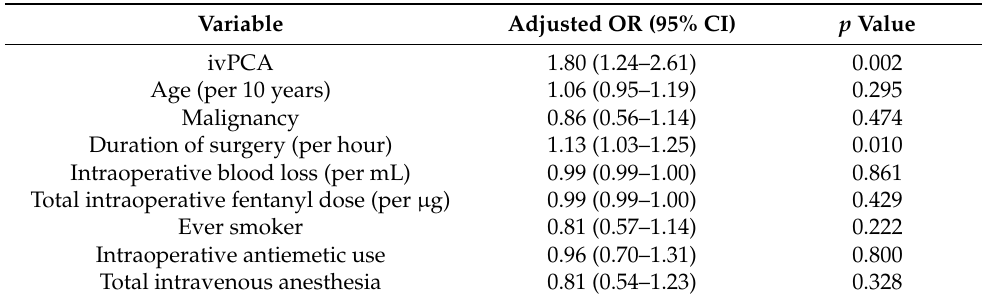
Table 2. Multivariable logistic regression analysis assessing the independent association between ivPCA use and CSE.